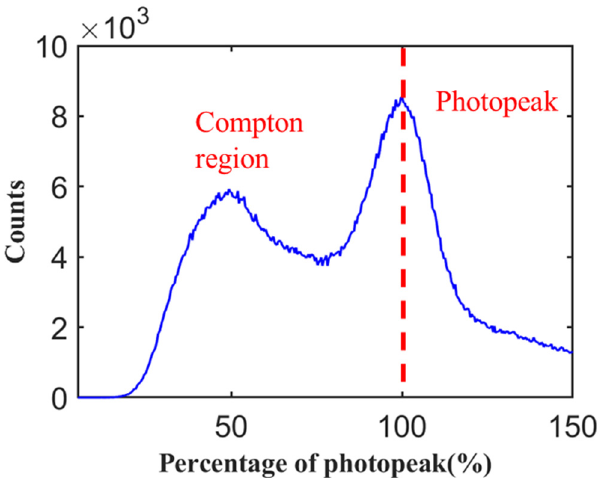
Figure 9. The energy spectrum of the crystal array constructed with ESR reflectors.